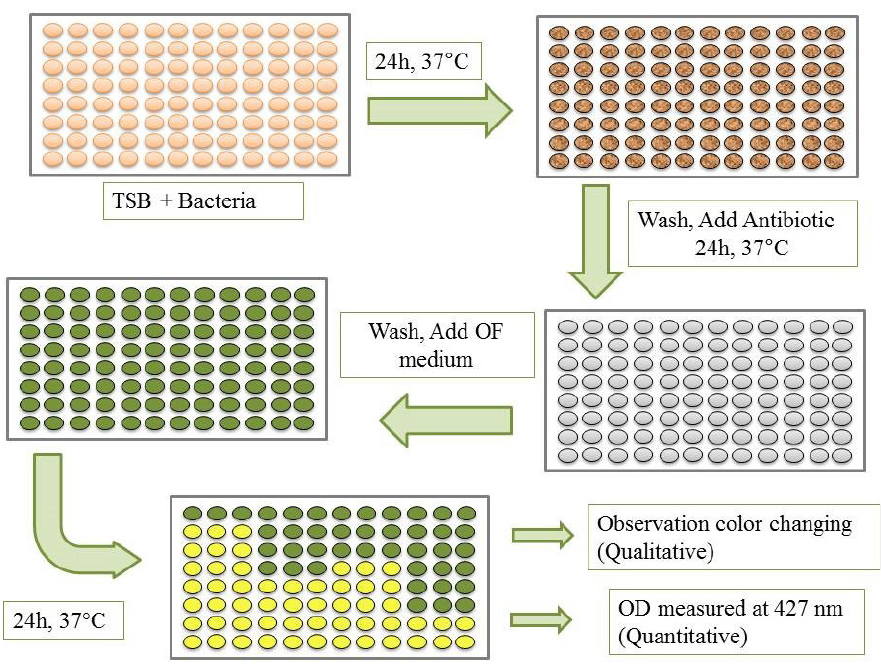
Figure 1. Schematic Chart of Susceptibility Biofilm-growing Bacteria Test. Note. Yellow well: Growth; Green well: No growth.